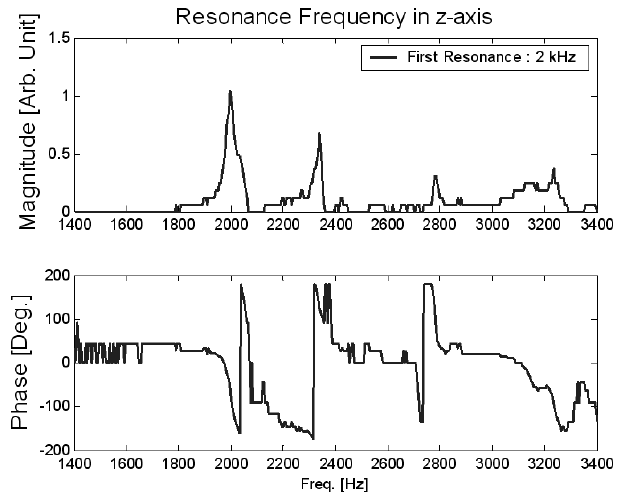
Figure 10. Resonances of the z